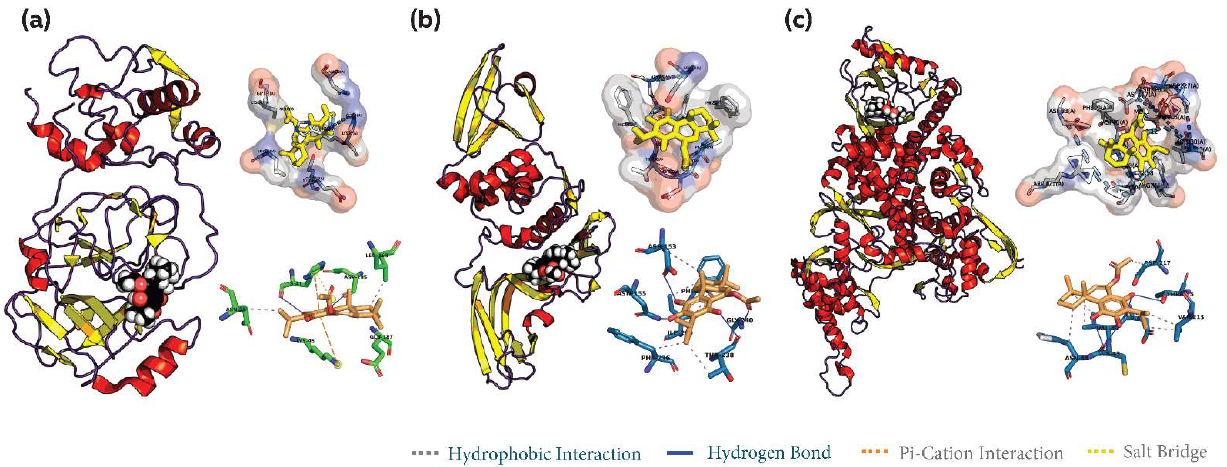
Figure 4. Analysis of the binding of the screened phytocompound hit (2751796) to the protein targets of the virus. The figure illustrates the binding and interaction analysis of ( a ) 2751796-Mpro, ( b